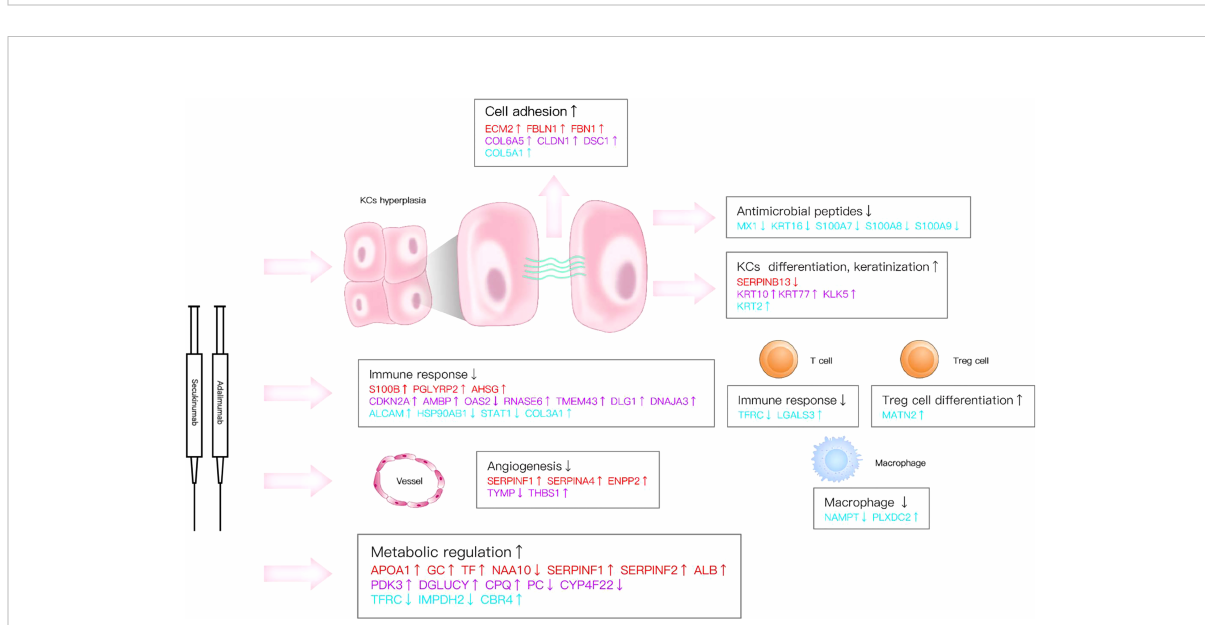
FIGURE 8 Key DEPs represent multiple molecule changes in psoriasis posttreatment. The fi gure shows only DEPs with FC>1.5. Proteins are involved in KC function, matrix components, metabolism and immune response based on their corresponding expression levels in the two biological agent groups. Red colour for protein names indicates the adalimumab group. Purple colour indicates the secukinumab group, and blue colour indicates the DEPs in both